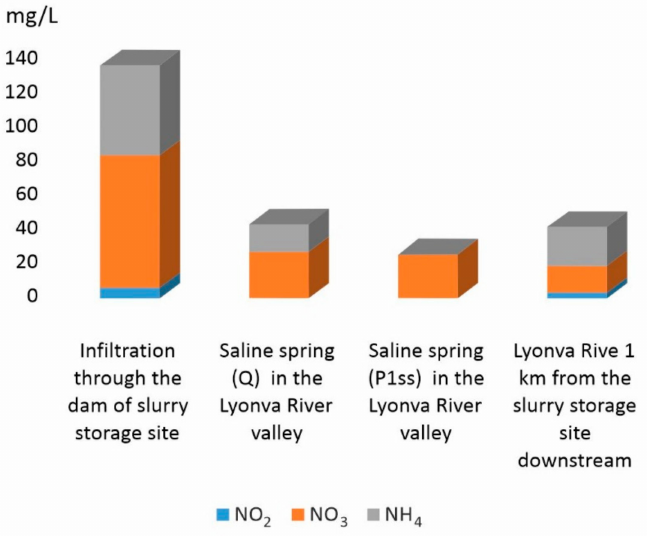
Figure 7. Concentrations of nitrogen compounds in drainage, groundwater and surface water in area effected by slurry storage